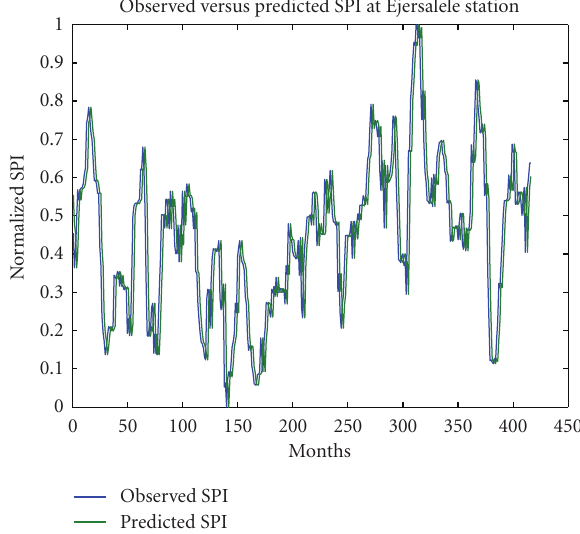
Figure 3: SPI 12 forecast results for the best ANN model at the Ejersalele station (1-month lead time).